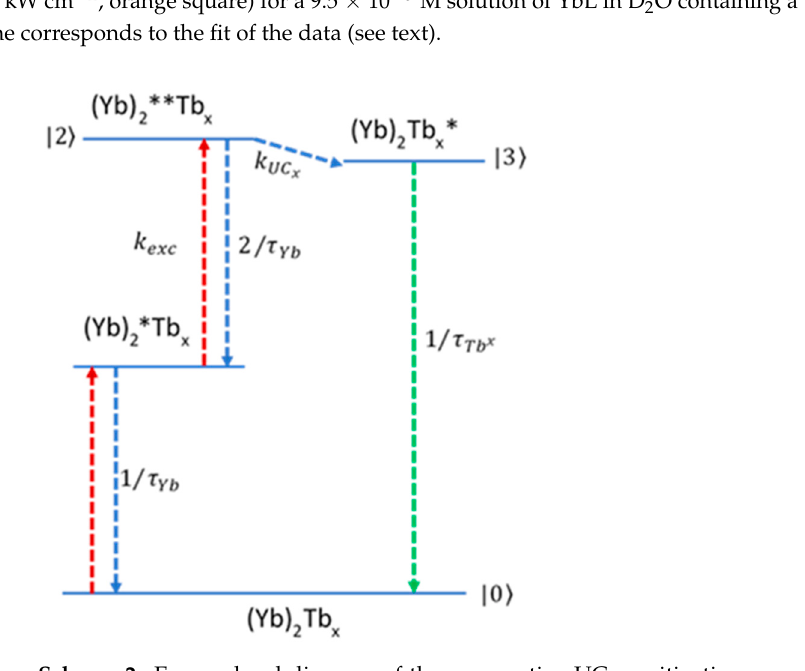
Scheme 2. Energy level diagram of the cooperative UC sensitization process in the [(YbL) 2 Tb x ] com- plex (x = 1–3). Symbols * and ** denote singly and doubly excited states